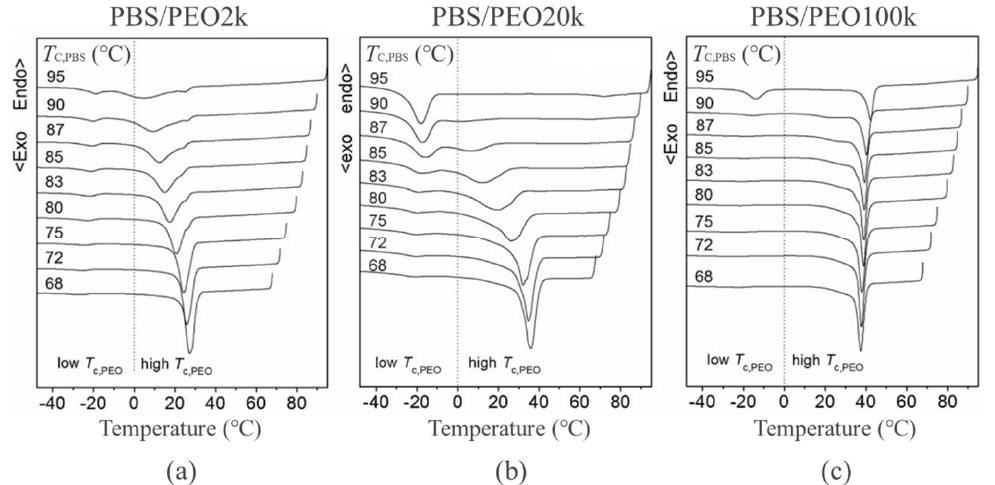
Figure 7. DSC cooling curves of poly(butylene succinate) (PBS)/poly(ethylene oxide) (PEO) 60/40 blends after the isothermal crystallization of the PBS component at different temperatures. Molecular weights of PEO are 2, 20 and 100 kg/mol in ( a – c ), respectively. The blends were first melted at 150 °C for 2 min and then cooled to T c,PBS at 100 °C/min and held for sufficient time for the crystallization of the PBS component. The sample was then cooled to − 50 °C at 10 °C/min to detect the crystallization of the PEO component [90,91]. Copyright 2013. Reproduced with permission from John Wiley & Sons.